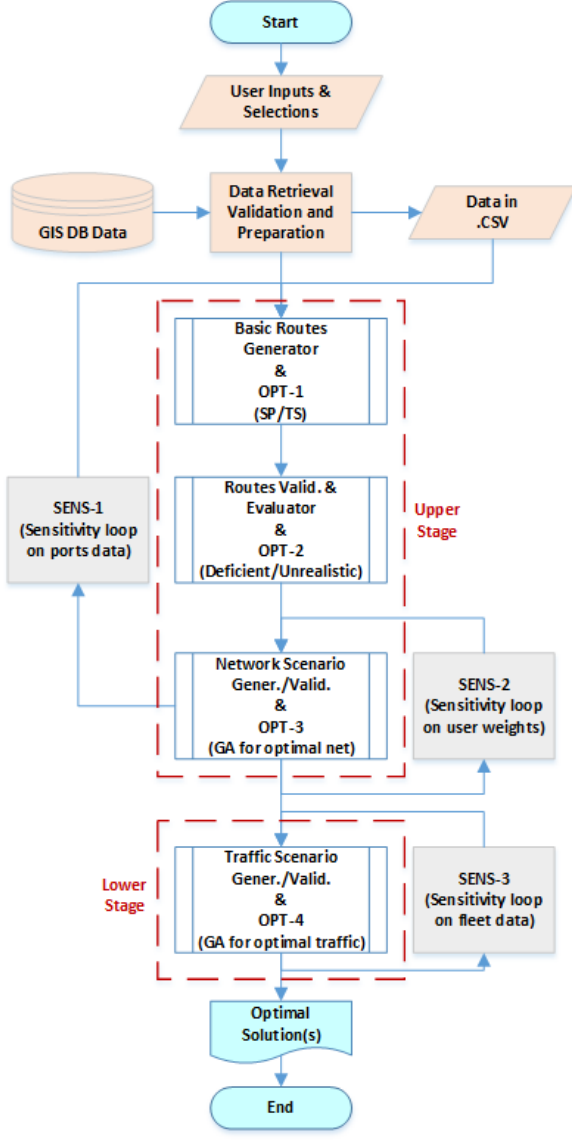
Figure 5. Co.Tr.I.S Design/Optimization Work